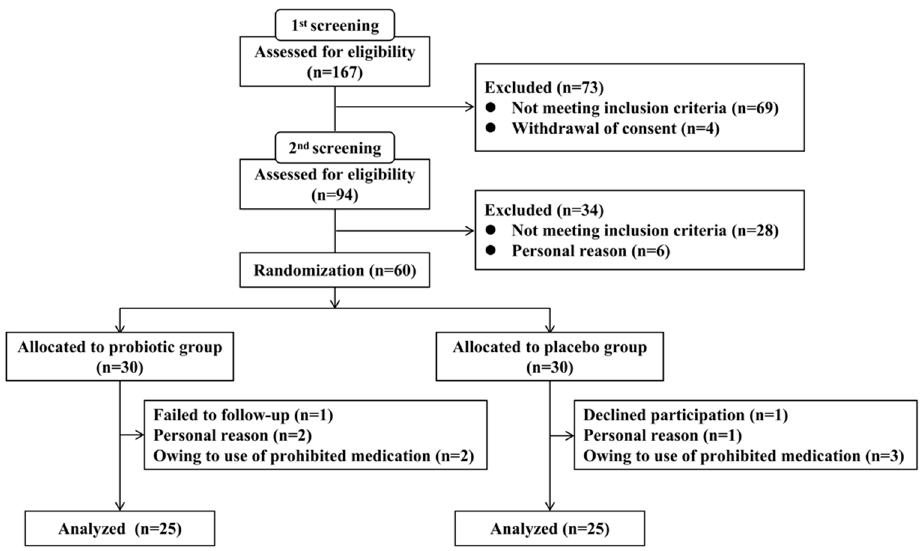
Figure 2. Trial profile. Table 1. Demographic data of the study subjects.